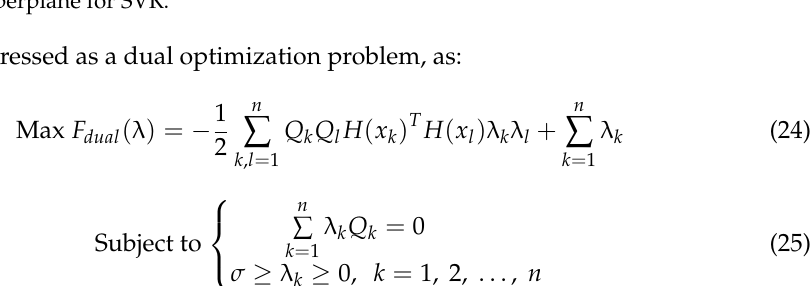
Figure 4. The hyperplane for SVR.